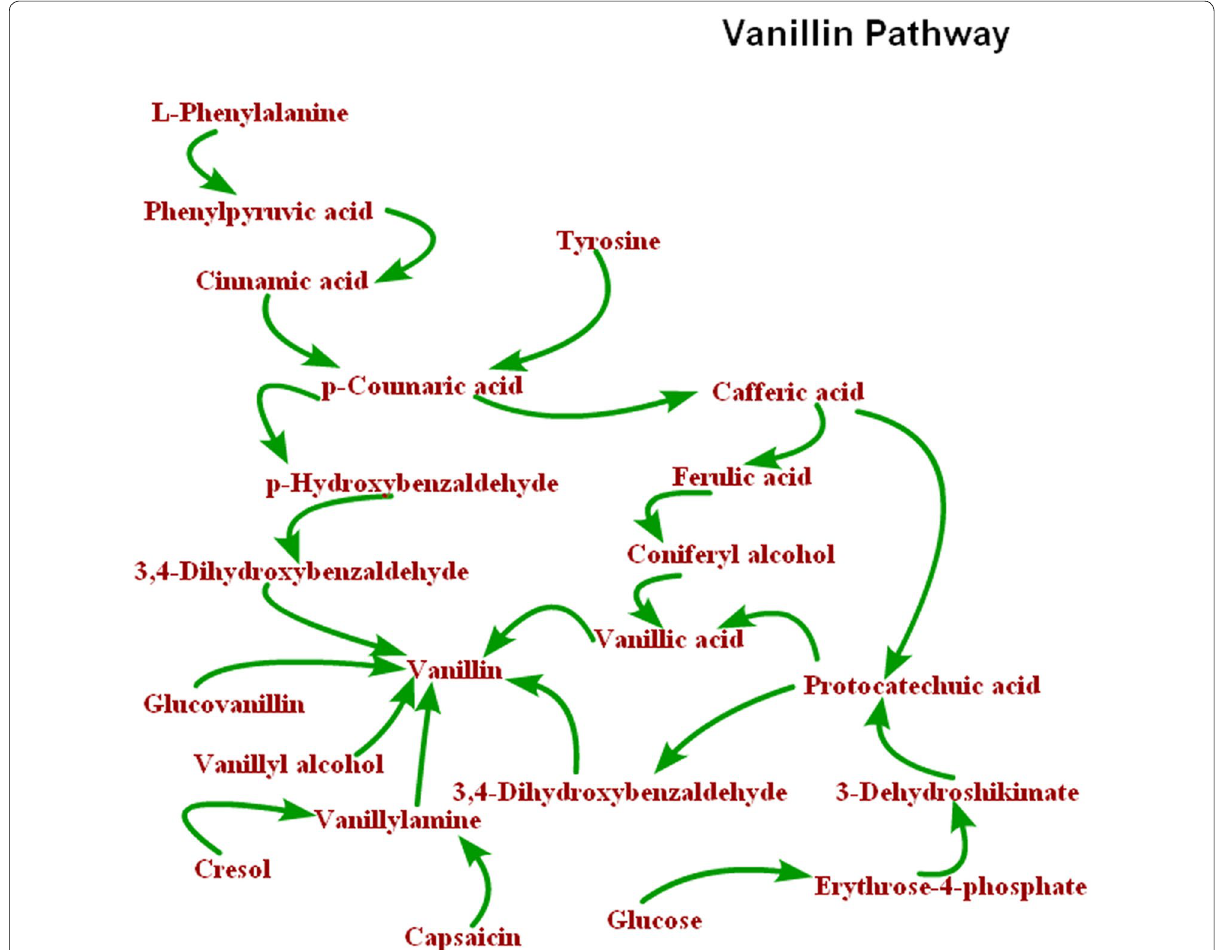
Fig. 6 Some presumed metabolic pathways of vanillin biosynthesis (cited from: the pathway of glucose, capsaicin, cresol, vanillyl alcohol, l -pheny- lalanine, tyrosine cited from Kaur and Chakraborty 2013; and the pathway of glucovanillin cited from Dignum et al.